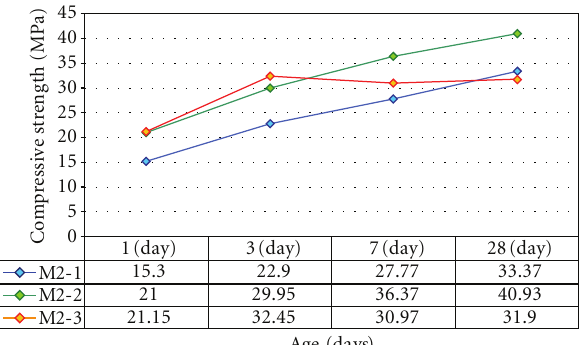
Figure 10: Compressive strength of the 3rd group.